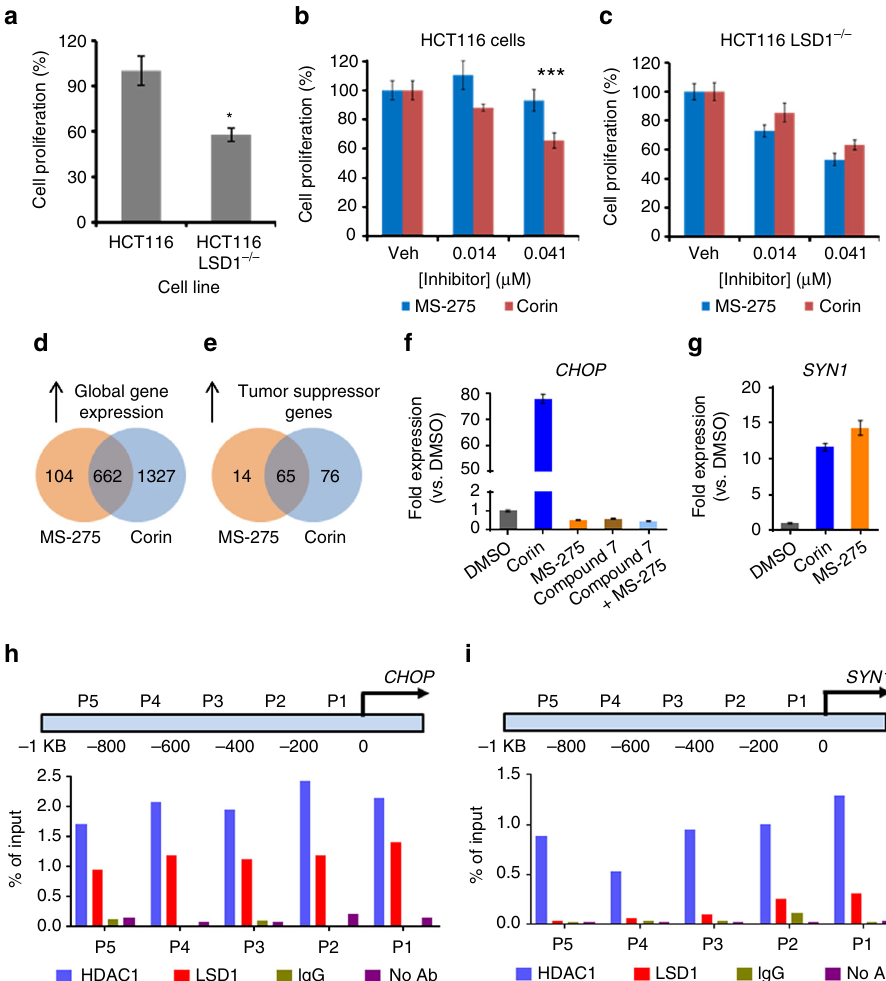
Fig. 5 Analysis of gene knockout effects in HCT116 cells and gene expression changes in melanoma associated with corin treatment. a Knockout of LSD1 in HCT116 cells decreased the rate of cancer cell proliferation by ~40% ( n = 4). b , c Knockout of LSD1 enhanced the potency of MS-275 but did not affect the potency of corin in HCT116 cells as determined by [ 3 H]thymidine incorporation after 48 h treatment ( n = 4). d , e Venn diagrams depicting increases in global and tumor suppressor gene transcription (fold change ≥ 2 σ , p < 0.05), respectively, upon 2.5 µ M MS-275 or corin treatment ( n = 3). f , g qRT-PCR validation of gene expression changes identi fi ed by microarray. WM983B melanoma cells were treated with inhibitor (2.5 µ M) for 24 h prior to RNA isolation and analysis ( n = 3). h ChIP-PCR localized CoREST complex components HDAC1 and LSD1 to the promoter region of CHOP ( n = 3). i ChIP-PCR localized HDAC1, but not LSD1, to the promoter region of SYN1 ( n = 3). Data (mean ± SEM) are representative of at least three independent experiments (unpaired t test, * p < 0.05, *** p < 0.001)